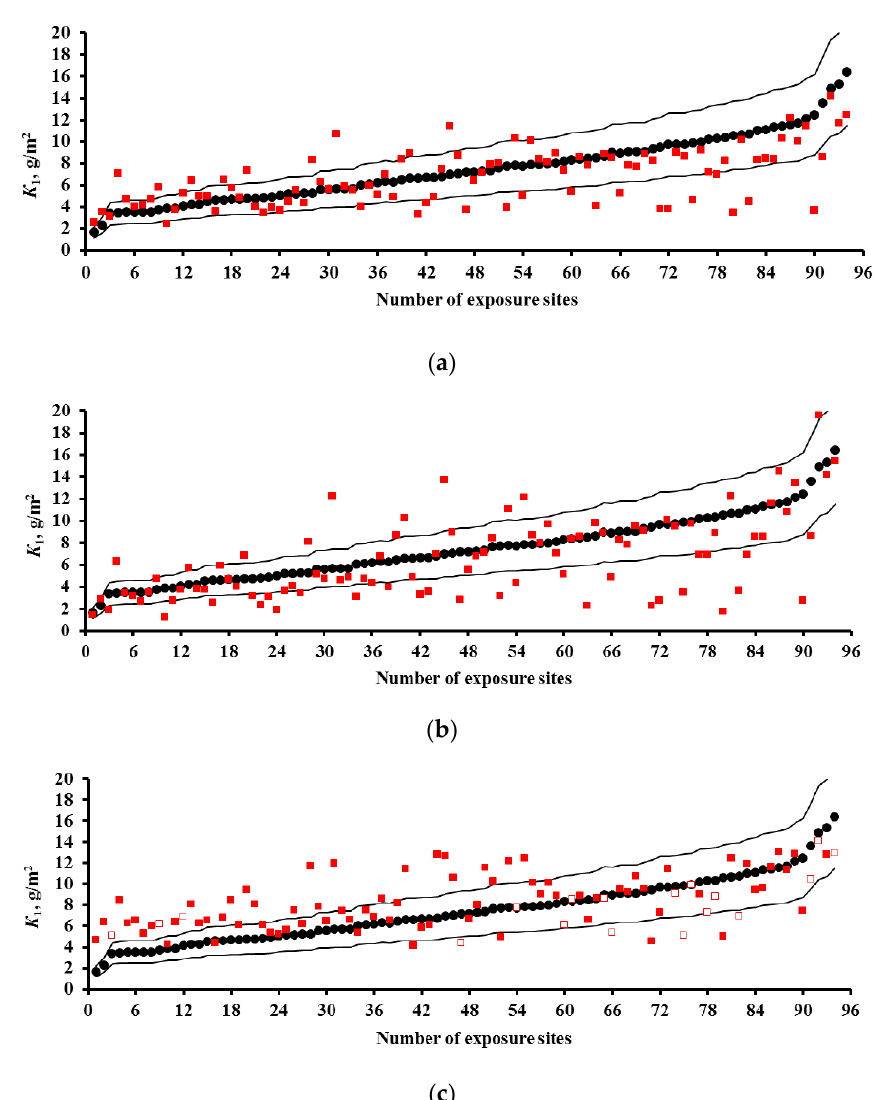
Figure 8. Zinc. UN/ECE program. K 1 predictions by the New DRF ( a ); Standard DRF ( b ); and Unified DRF ( c ). ● —experimental K 1 data; ■ — K 1 predictions. □ — K 1 predictions without taking [ Н + ] into account (only for the Unified DRF). Thin lines show the calculation error ( ± 30%). The numbers of the exposure sites are given in accordance with Table 2.